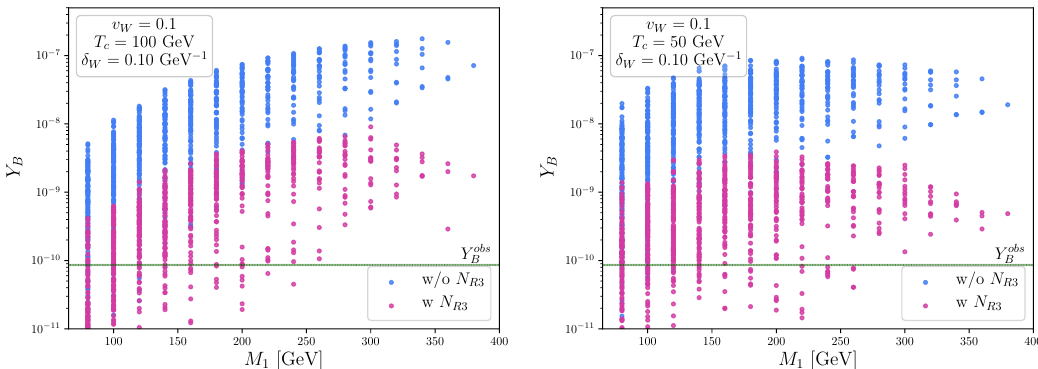
Figure 10 . Final BAU generated in the (cid:13)avoured scenario for di(cid:11)erent masses of the singlet neutrinos and two temperatures for the phase transition, T c = 100 GeV (left panel) and T c = 50 GeV (right panel). The mass ranges are M 1 [80 ; 400] GeV, M 2 [ M 1 + 10 ; 400] GeV and 2 2 M 3 [ M 2 + 10 ; 400] GeV, scanned in steps of 20 GeV, while m D has been (cid:12)xed as discussed at the 2 end of section 2. For the blue dots the contribution of N R 3 has been neglected as in eq. (4.12), while the magenta points overestimate its importance, as described at the end of section 4.2.